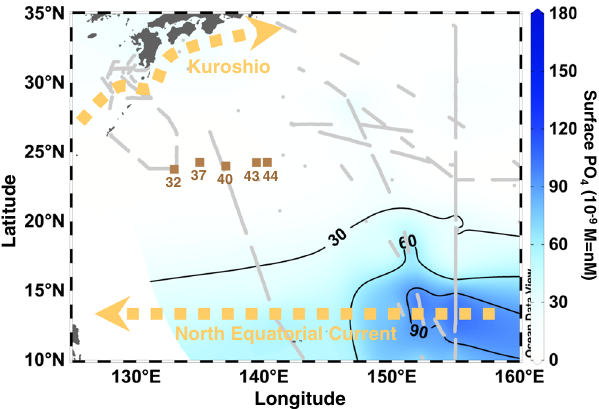
Fig. 1 Study areas and sampling stations. Stations are indicated by the brown squares. Typical fl ow paths of Kuroshio and North Equatorial Current are depicted by the yellow dashed arrows. The background contour shows surface (< 10m) nanomolar phosphate (PO 4 ) concentrations reported in our previous studies 20,21 . The gray dots and gray lines denote sampling stations and underway continuous sampling tracks for the nanomolar PO 4 ,